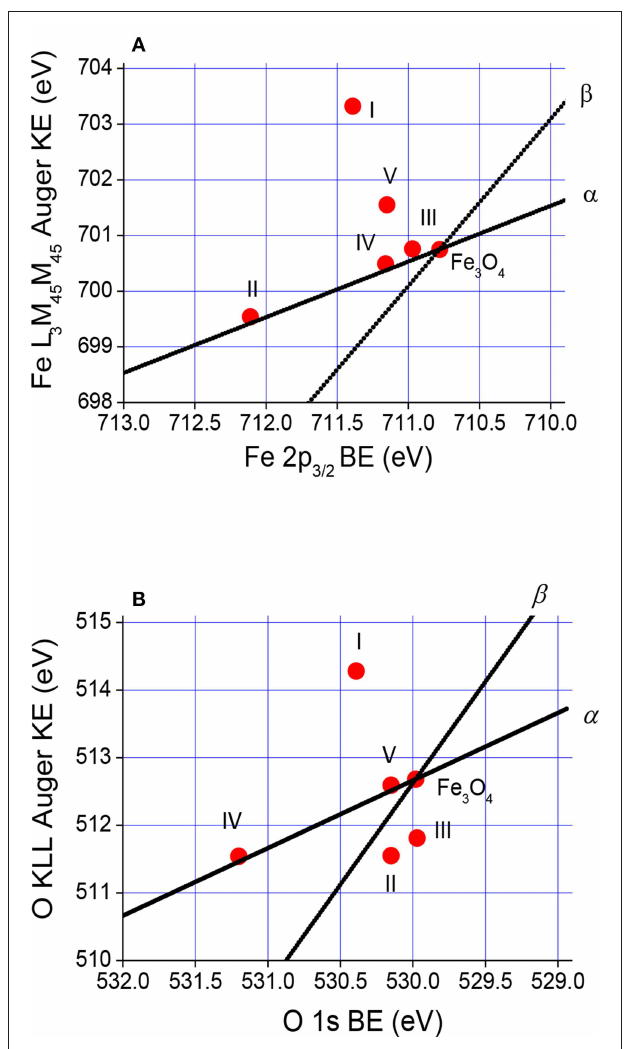
FIGURE 8 | Wagner plots for (A) Fe L 3 M 45 M 45 and Fe 2p 3 / 2 spectra and (B) O KLL and O 1s spectra representing the investigated Fe 3 O 4 MNPs and Fe 3 O 4 f-MNPs